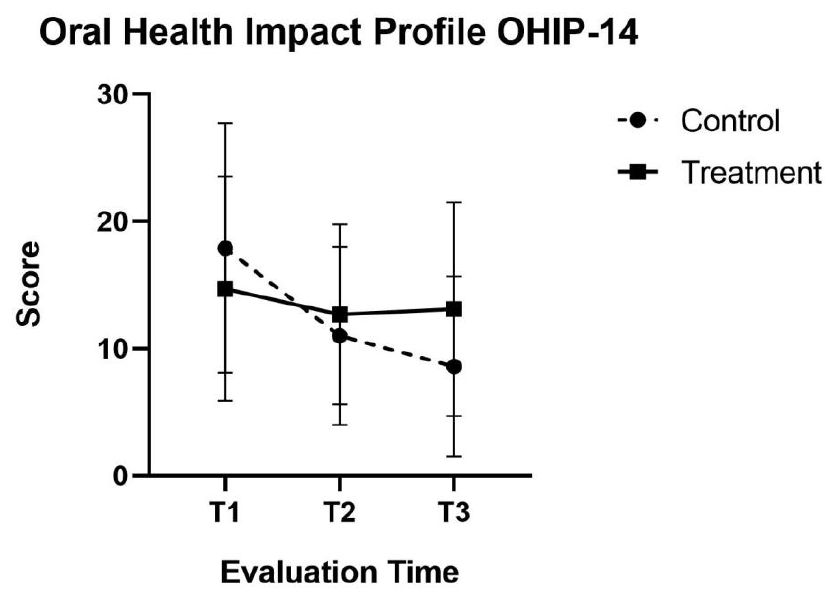
Figure 3. Health Impact Profile (OHIP-14) Graphs comparing mean ( ± SD) score at baseline (T1), After 2 weeks of therapy final session (T2) At the end of therapy 6 weeks(T3) active laser and control group.